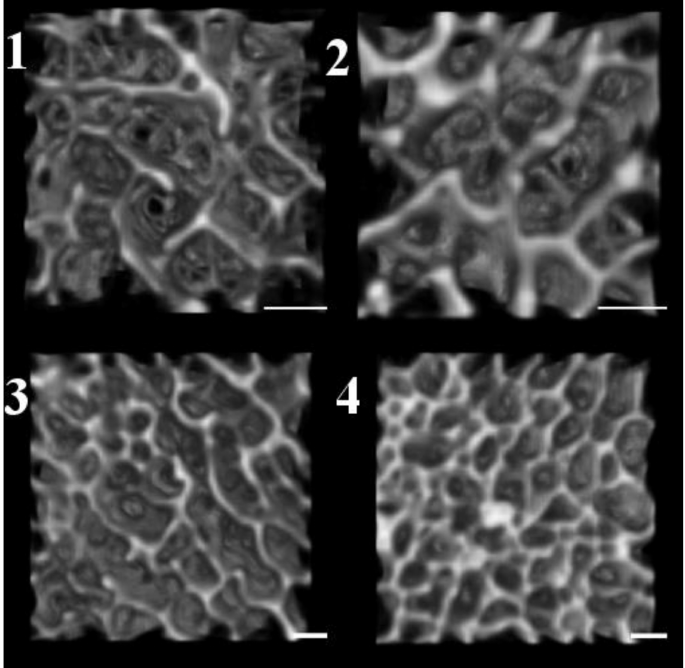
Figure 4. Volume of interest visual representation for each age category. 1 = Category 1 (9-year-old unknown sex); 2 = Category 2 (16-year-old male); 3 = Category 3 (26-year-old male); 4 = Category 4